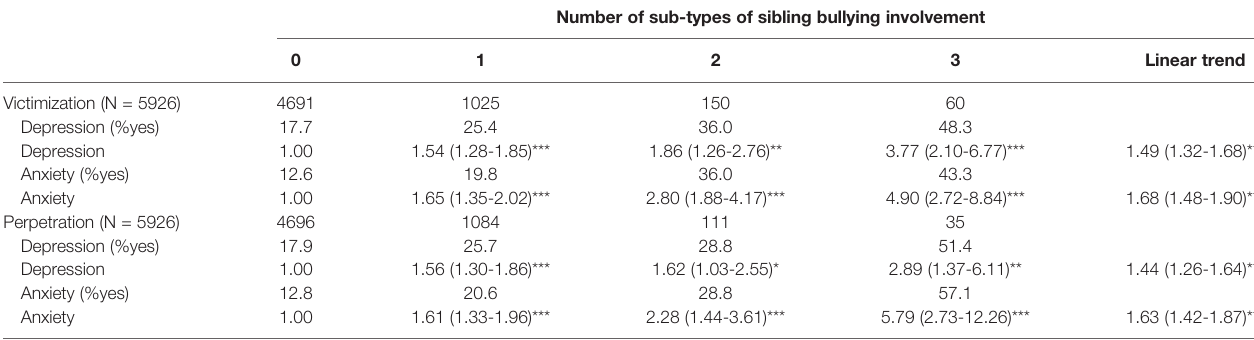
TABLE 4 | The associations between the number of sub-types of sibling bullying involvement and depression and anxiety [Adjusted OR (95%